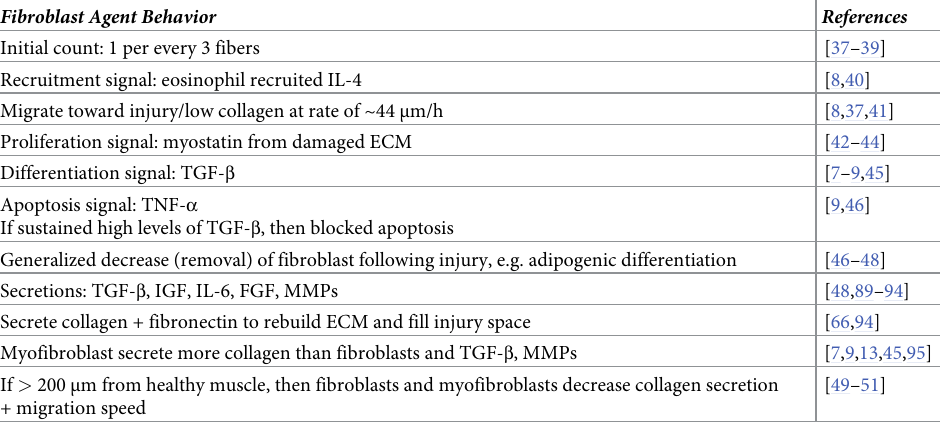
Table 1. Fibroblast agent behaviors were defined by literature derived rules. Fibroblast Agent